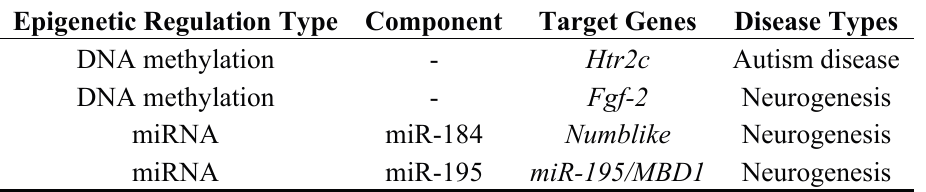
Table 2. Regulatory mechanisms and diseases of the nervous system related to